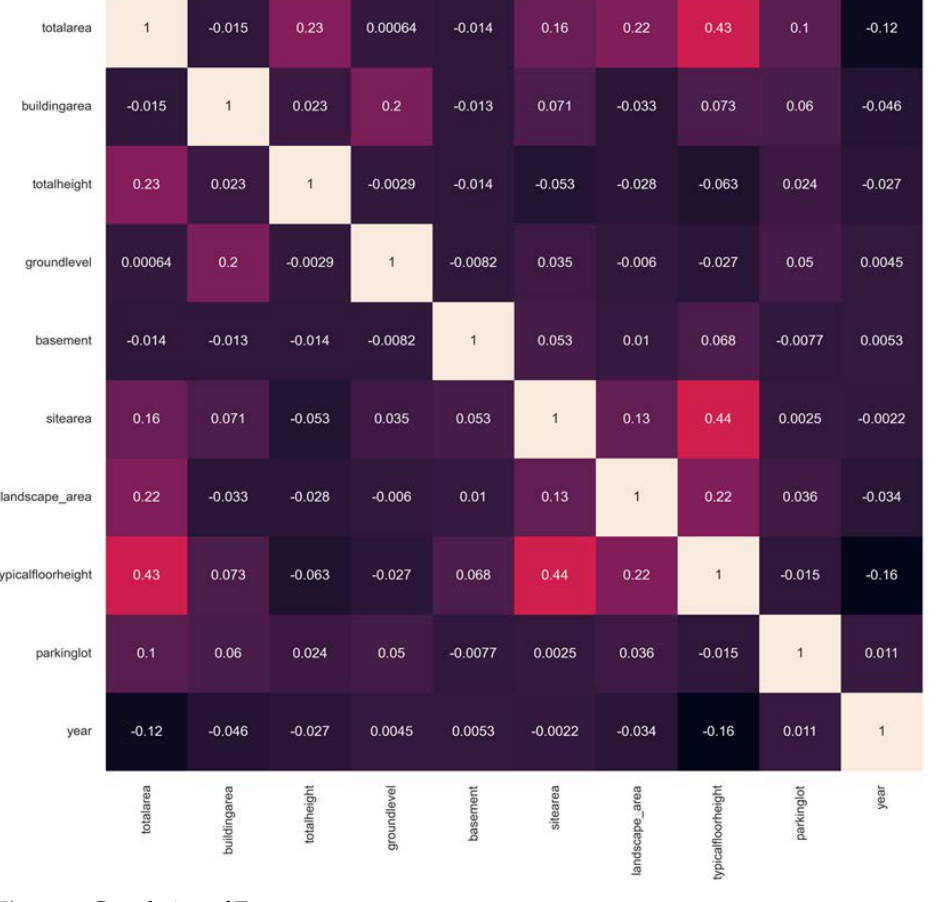
Figure 4. Correlation of